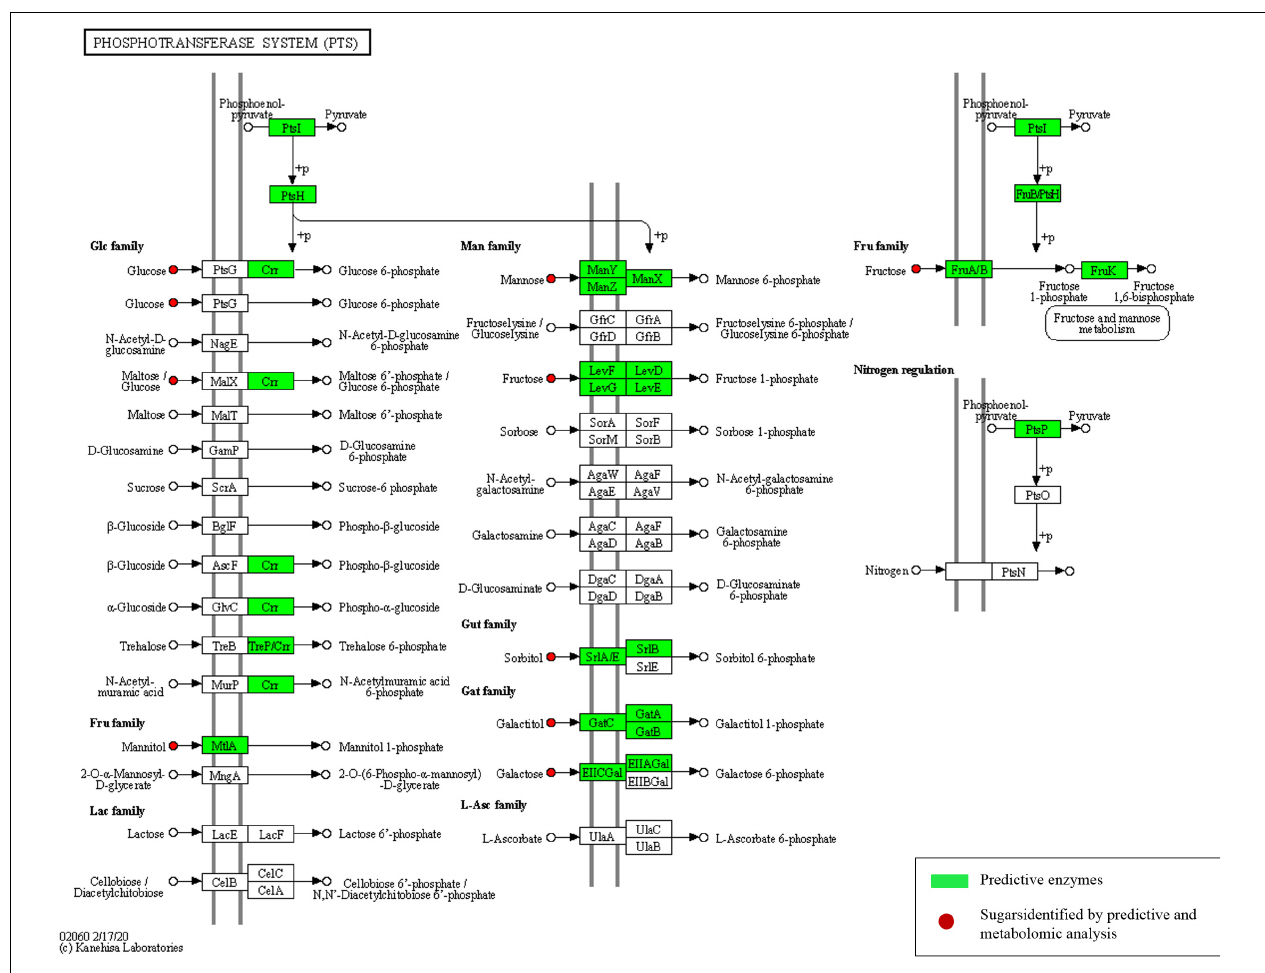
FIGURE 7 | Predictive enzymes involved in phosphotransferase system